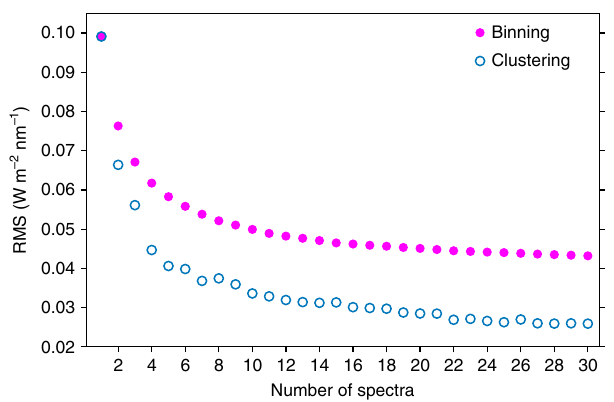
Fig. 2 Spectral classi fi cation error. Root mean square statistics relative to the cluster (or bin) center for the clustering and binning methods as a function of the number of clusters (or